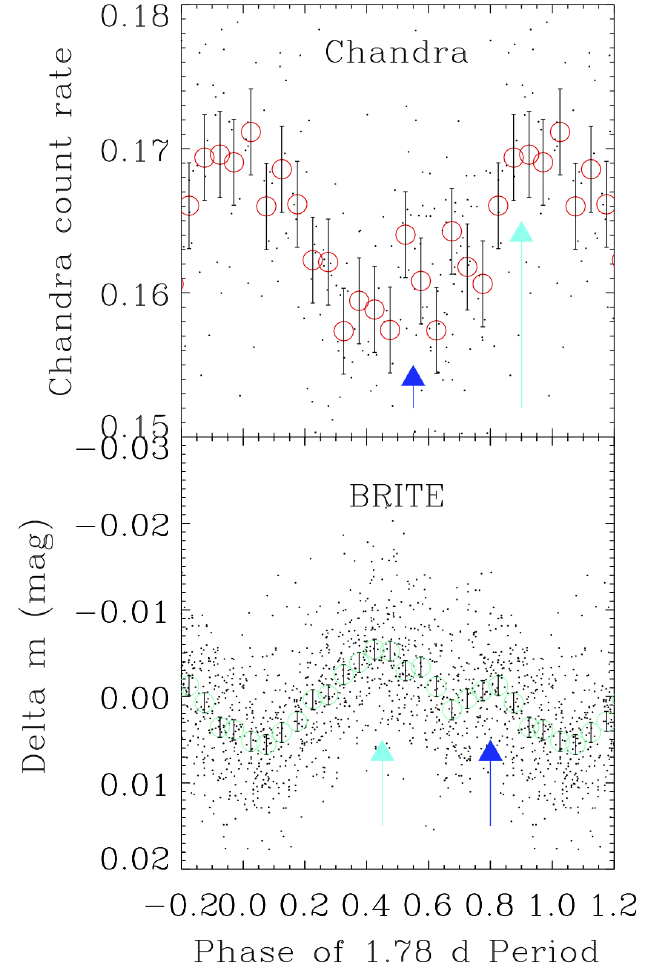
Figure 8. Simultaneous light curves of ζ Pup in X-rays ( Chandra ) and optical ( BRITE ), obtained in 2018–2019, phased according to the 1.78 d ephemeris [28]. Cyan arrows denote a primary peak, blue arrows a secondary peak in each LC. Both the original data and bins with 2 σ error bars are shown in each case. The peak-to-valley amplitudes are 6% and 1% in X-rays and optical, respectively. The scatter about the optical light curve is mostly intrinsic, while that for the X-ray light curve is mostly Poisson noise. ©AAS. Reproduced with